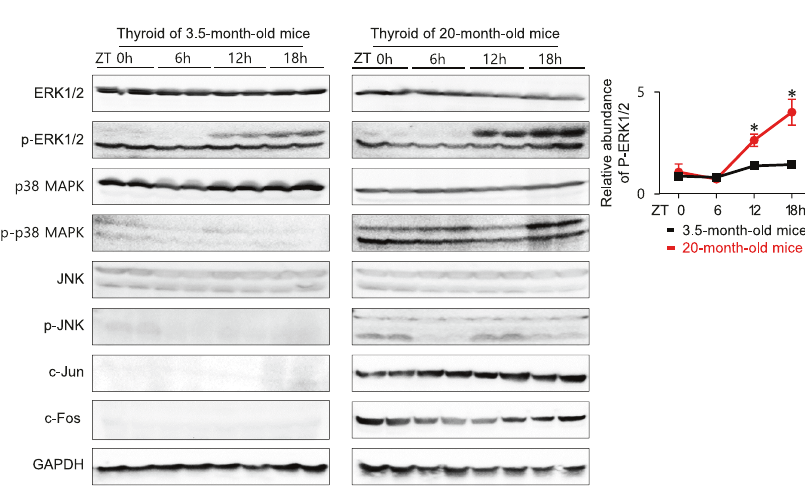
Fig. 3 Change of circadian oscillation of peripheral clock genes associated with aging. A mRNA expression of Clock , Arntl/Bmal1 , Rev-erb α , Per2 , Per3 , and Cry1 in the murine liver of 3.5- and 20-month-old mice at the indicated times. Cosinor-based rhythmometry analysis is used to determine the rhythmic expression of clock genes in the liver of 3.5- and 20-month-old mice. Hepatic oscillation of Clock , Arntl/Bmal1 , Rev-erb α , Per2 , Per3 , and Cry1 expression is preserved in 20-month-old mice. B mRNA expression of Clock , Arntl/Bmal1 , Rev-erb α , Per2 , Per3 , and Cry1 in the murine thyroid of 3.5- and 20-month-old mice at the indicated times. Cosinor-based rhythmometry analysis is used to determine the rhythmic expression of clock genes in the thyroid of 3.5- and 20-month-old mice. Rhythmic expression of Per2 and Per3 is signi fi cantly lower in the thyroids of 20-month-old mice than in those of 3.5-month-old mice. Each point represents mean ± SEM values of three independent assays ( n = 3). C Immunoblot analysis of thyroids from 3.5- and 20-month-old mice (ZT 0, 6, 12, 18 h; n = 2 mice/timepoint) con fi rms alterations in protein levels of ARNTL/BMAL1 and PER2 consistent with alterations of mRNA levels. GAPDH is used as a loading control. Comparisons are made at individual time points between groups and statistical differences are indicated as * p < 0.05, ** p < 0.01, *** p < 0.001. D Immunohistochemistry for PER2 in the thyroid of 6-week-old and 30-month-old mice. PER2 is diffusely expressed in the cytoplasm of the follicular epithelium of 6-week-old murine thyroid. The expression of PER2 is very weak in the 30-month-old murine thyroid. Scale bar, 100 μ m.